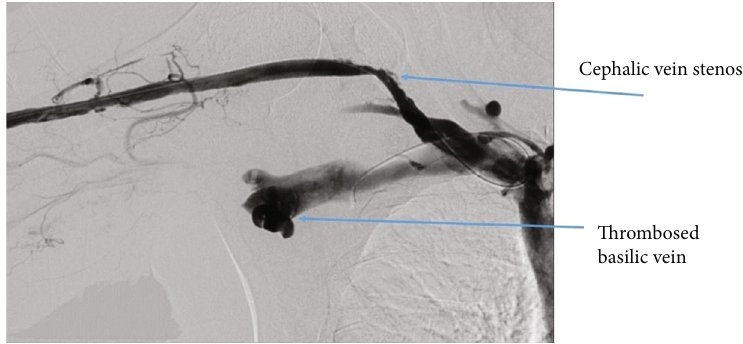
Figure 2: Out fl ow obstruction — cephalic vein stenosis and basilic vein thrombosis.